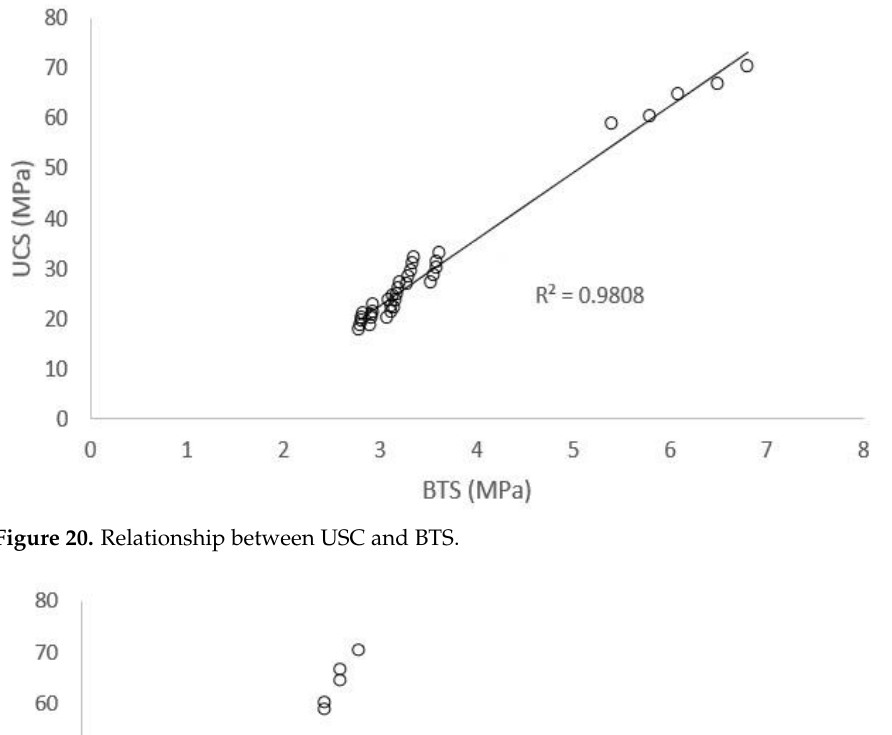
Figure 20. Relationship between USC and BTS.